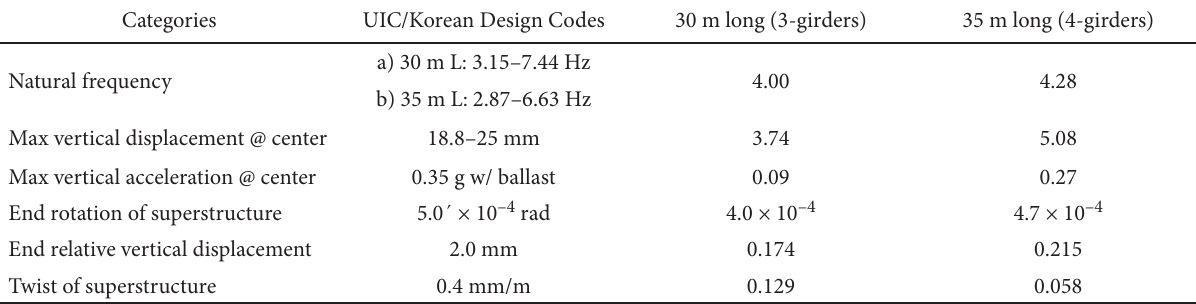
Table 1. Summary of dynamic responses of simply supported small boxed PSC girder bridge under KTX (TGV) vehicle